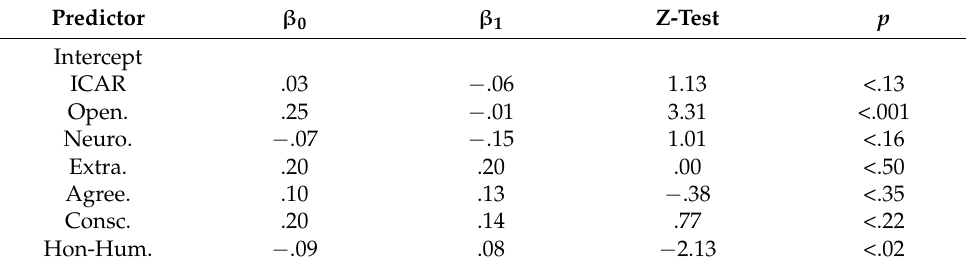
Table 3. Significance testing of differences between the impacts of personality traits in the Mturk and Mensa samples for predicting work engagement